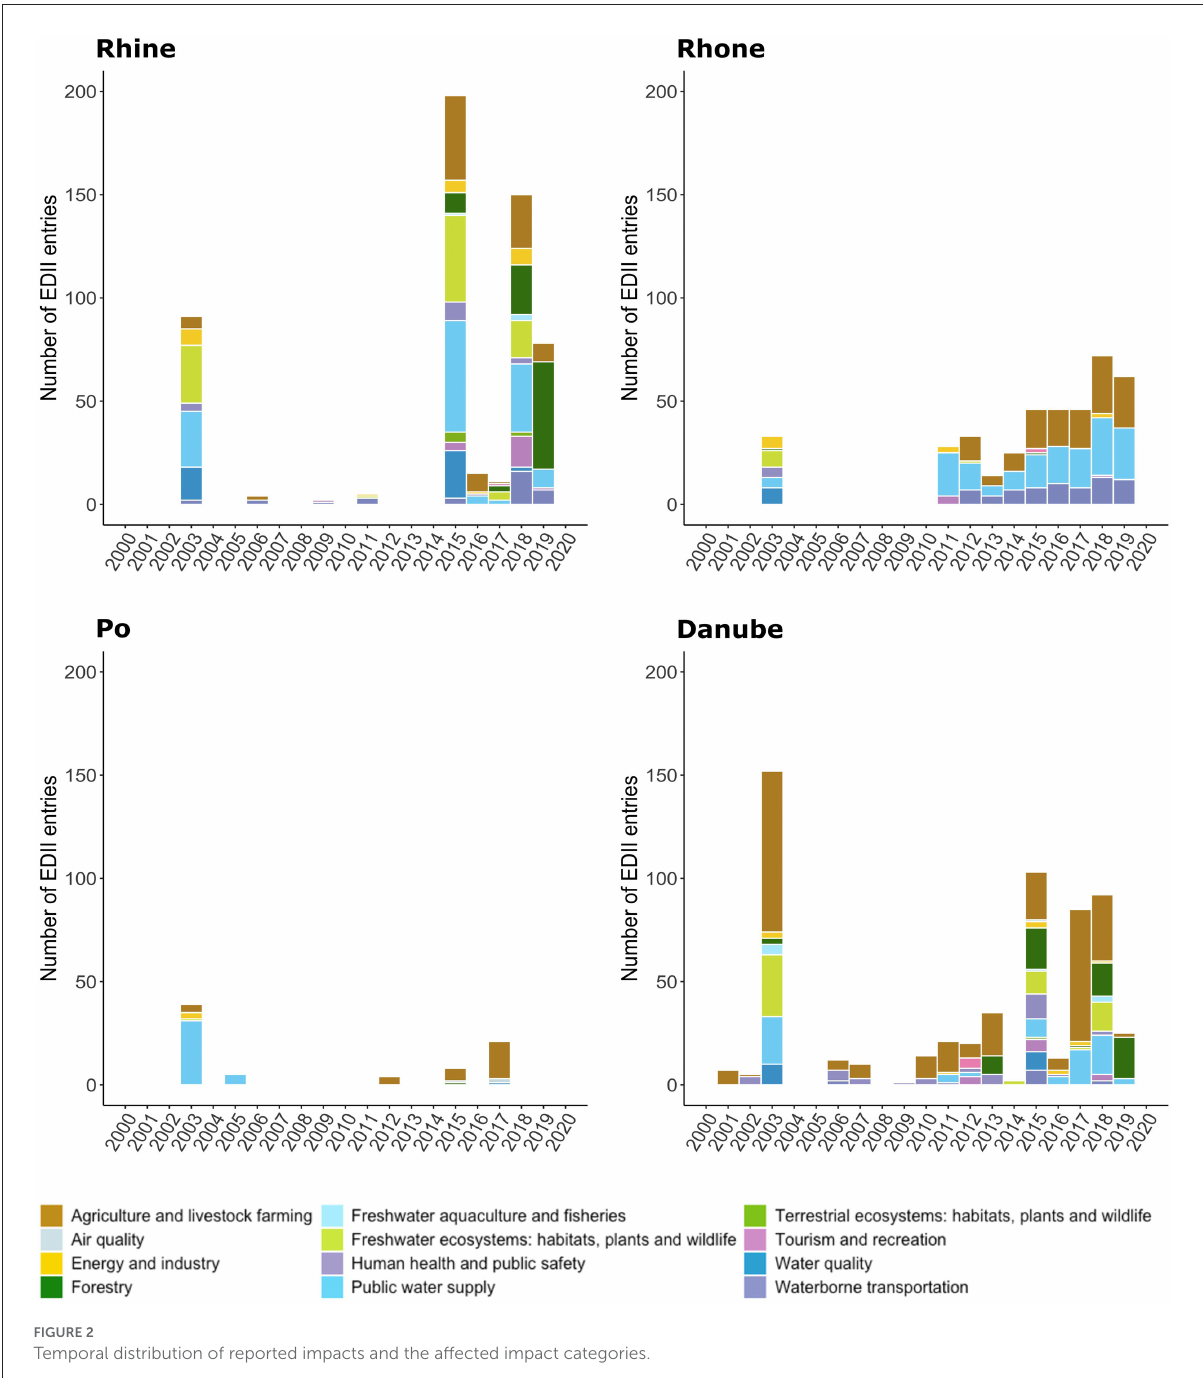
FIGURE2 Temporal distribution of reported impacts and the affected impact categories.